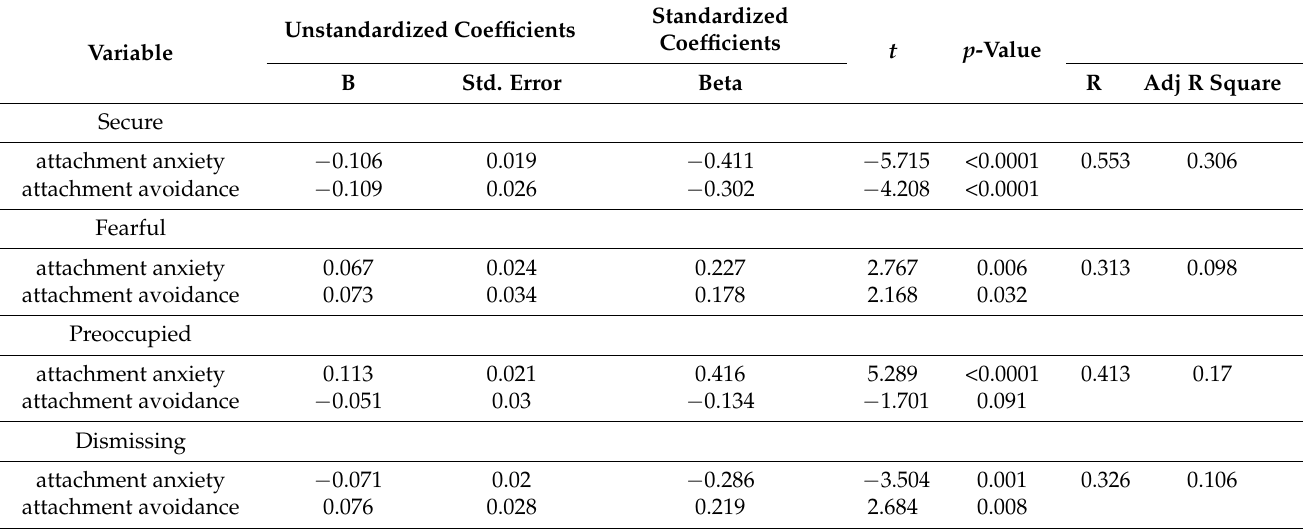
Table 4. Predicting coefficients of RQ styles (categorical) by ECR-r (original data using the whole sample).